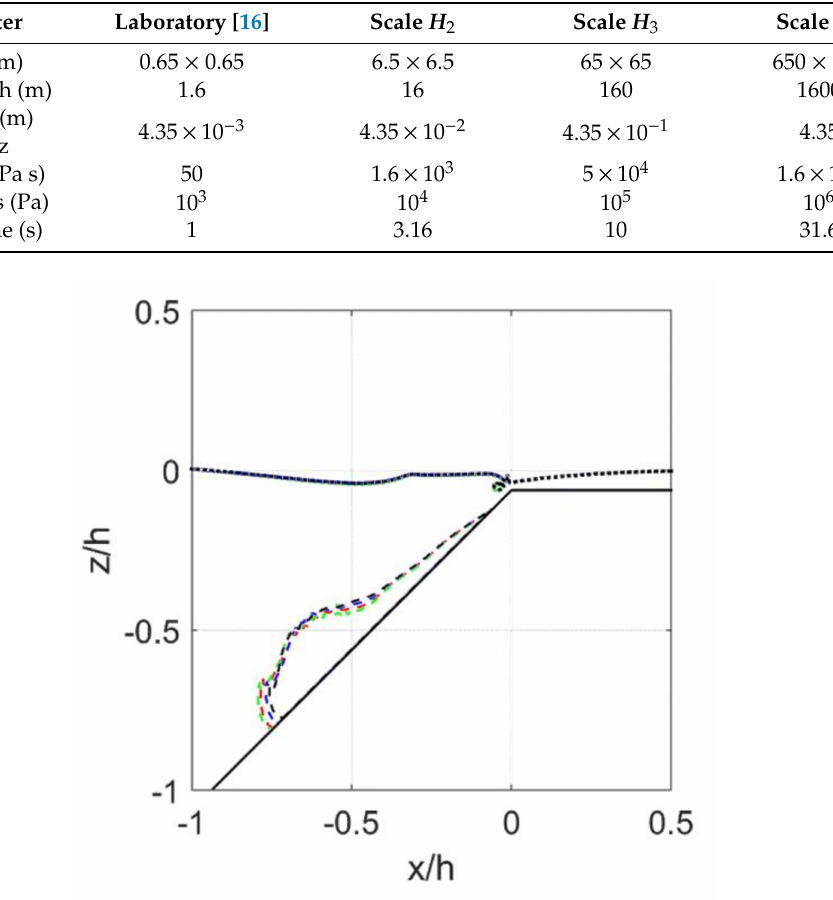
Figure 11. The similarity of water free-surfaces and slump profiles in di ff erent length scales, represented by water depth H 1 (black color), H 2 = 10 H 1 (blue color), H 3 = 100 H 1 (green color), and H 4 = 1000 H 1 √ √ (red color) at t 1 s, t 2 = 10 t 1 s, t 3 = 10 t 1 s, and t 4 = 10 10 t 1 s,